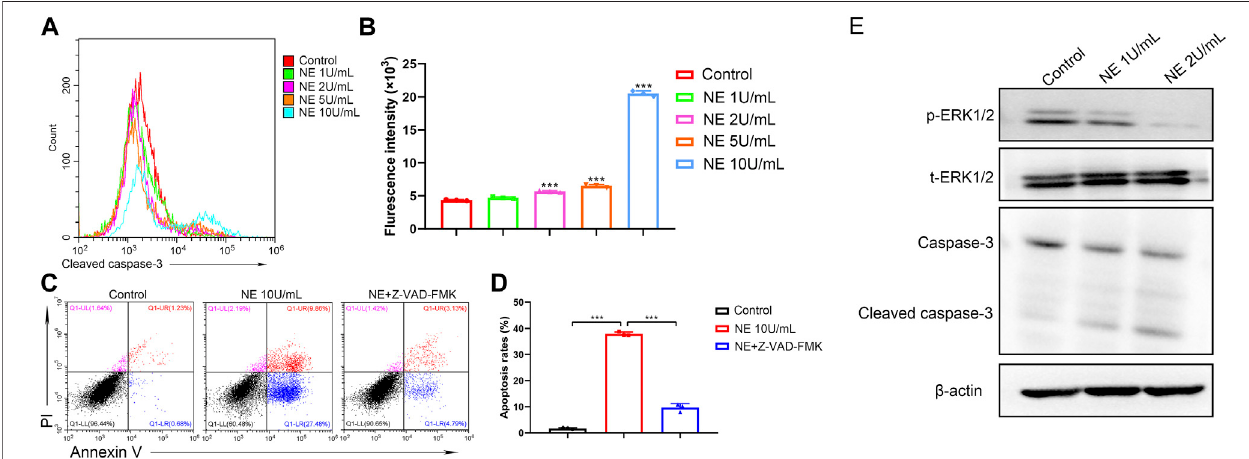
FIGURE 3 | Neutrophil elastase induces chondrocytes apoptosis through cleaved caspase-3 . (A) Representative histograms of cleaved caspase-3 levels of chondrocyteswereshown. (B) Cellassociatedmeanrelative fl uorescenceintensities.Dataaremean ± SEM; n (cid:1) 3.*** p < 0.001. (C) The fl uorescencepatternofannexin V-FITC/PI staining chondrocytes. (D) Percentages of annexin V positive cells for chondrocytes treated with NE and Z-VAD-FMK. Data are mean ± SEM; n (cid:1) 3. *** p < 0.001. (E) Western blot of ERK1/2 phosphorylation, total ERK1/2, caspase-3 and cleaved caspase-3 levels of chondrocytes treated with NE.